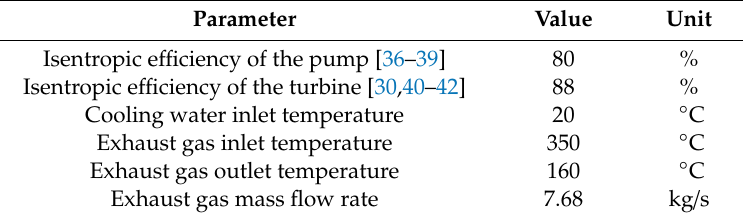
Table 2. The accepted nominal working parameters for ORC.